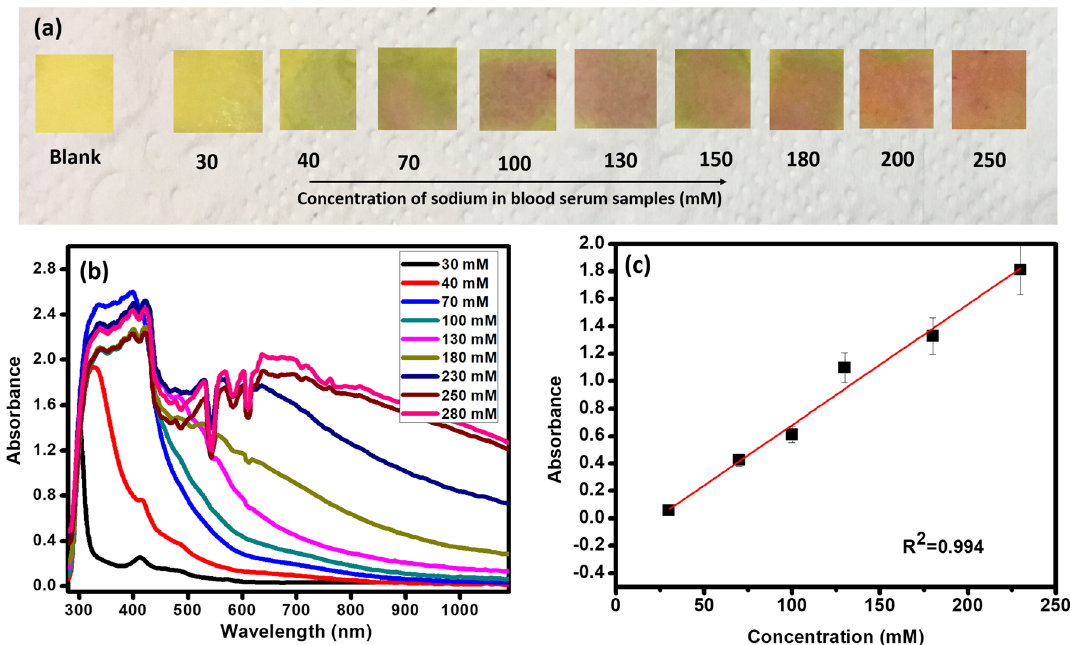
Figure 10. ( a ) Photograph of CuC-paper test strips exposed to blood serum samples with varying concentrations of Na + . ( b ) Absorbance spectra of blood serum samples upon the addition of CuC sensing solution. ( c ) Curve fitting showing the linear responses of absorbance Vs Concentration at 557 nm. Error bars represent standard error of the mean (n =